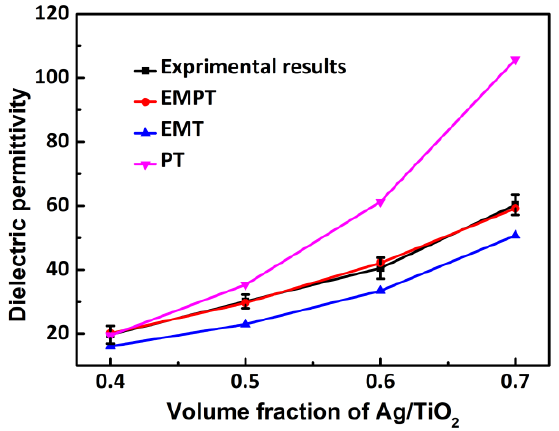
Figure 8. Experimental and theoretic values of ε r of Ag/TiO 2 /PTFE composites with different volume fractions of Ag/TiO 2 at 1 kHz and at room temperature.